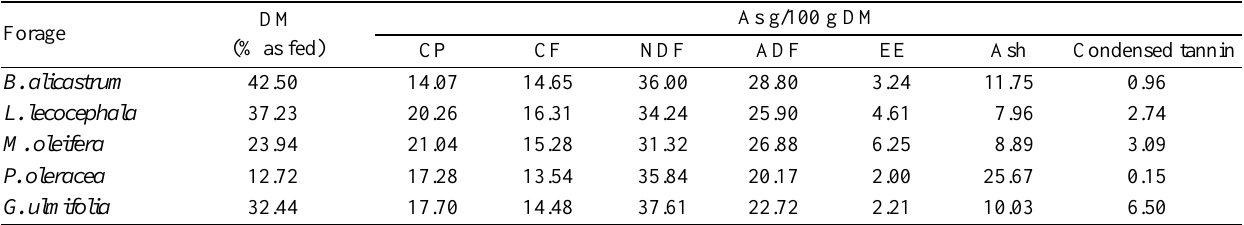
Table 2. Chemical composition of the studied forages (DM basis) Forage